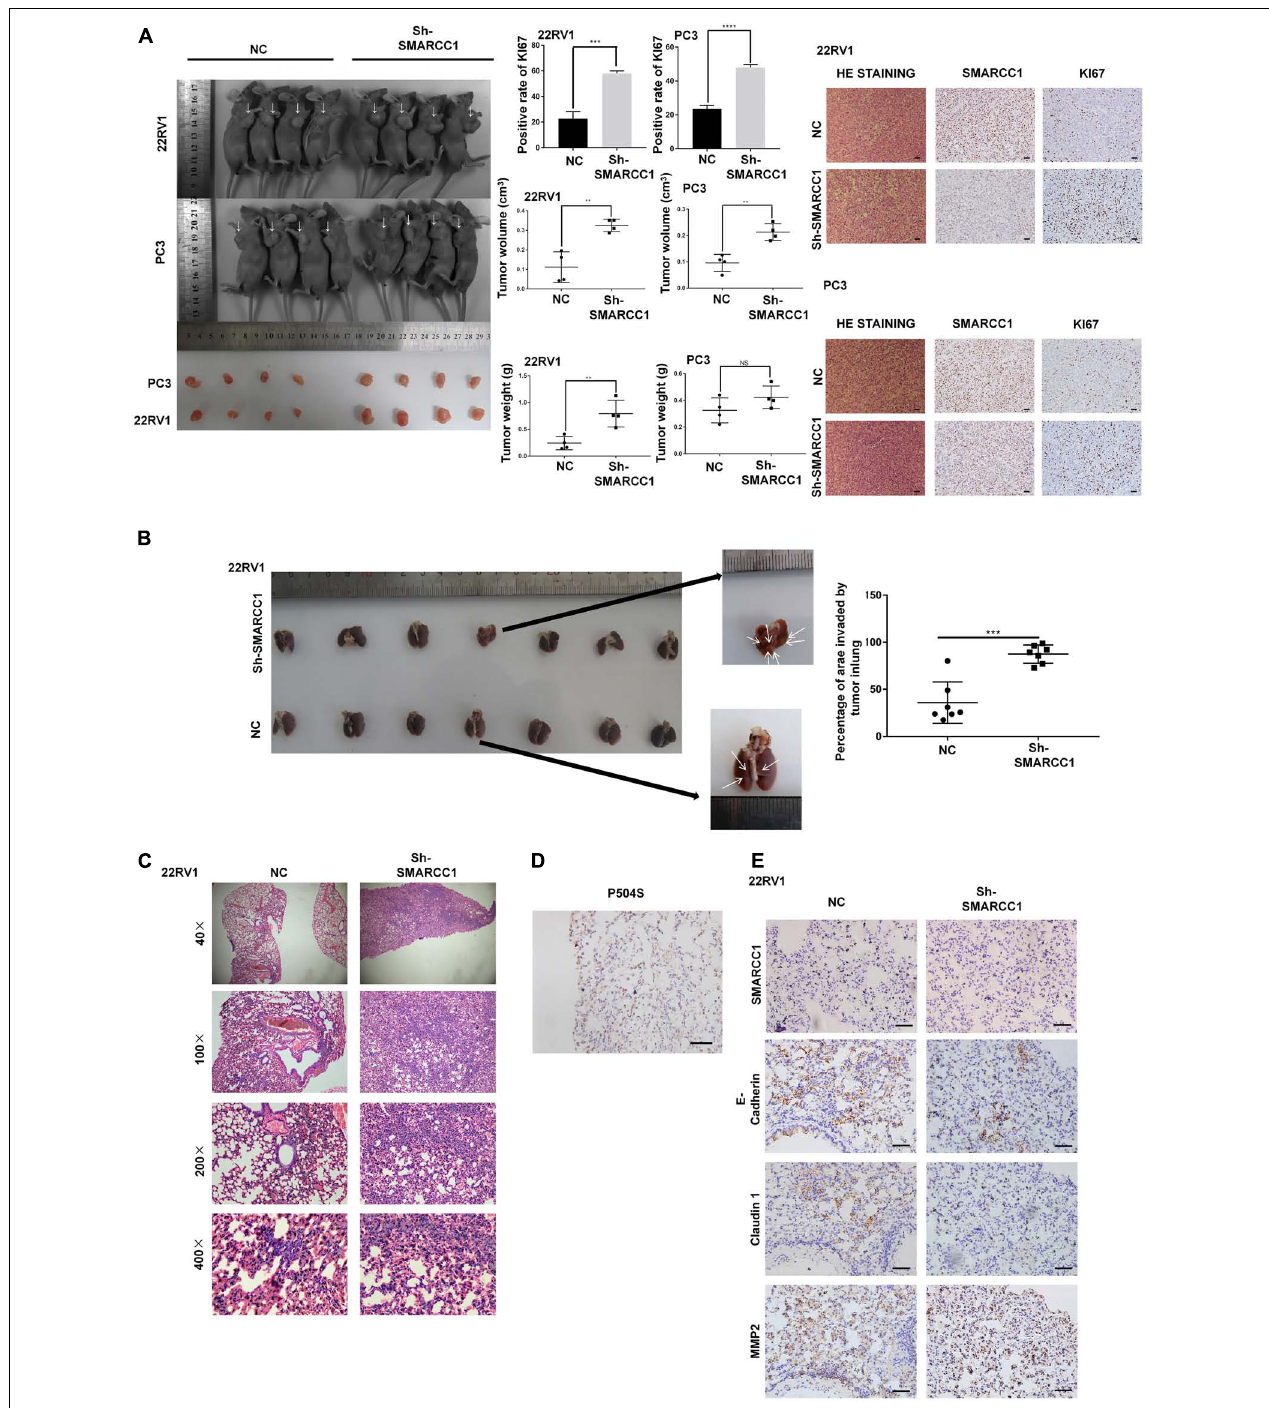
FIGURE 4 | SMARCC1 knockdown promoted tumor growth and metastasis in vivo . (A) Left panel: representative images of subcutaneous tumor xenografts in the indicated groups and scatter plots showing tumor volume and weight. Right panel: representative immunohistochemistry (IHC) images showing SMARCC1 and KI67 expression (magnification, × 200; scale bar, 20 µ m) and bar graph showing the percentage of KI67+ cells. (B,C) Schematic illustration of lung metastasis model. Representative images of H&E-stained tumor nodules and scatter plots showing the percentage of lung area invaded by PCa cells in the indicated groups. (D) Representative IHC images of metastatic nodules showing the positive staining of P504S indicative of prostate origin (magnification, × 400; scale bar, 20 µ m). (E) Representative IHC images of metastatic nodules showing the in situ expression of SMARCC1 , MMP2, E-cadherin, and claudin1 (magnification, × 400; scale bar, 20 µ m). All data were presented as mean ± SEM of at least three independent experiments. ** p < 0.01; *** p < 0.001; **** p <